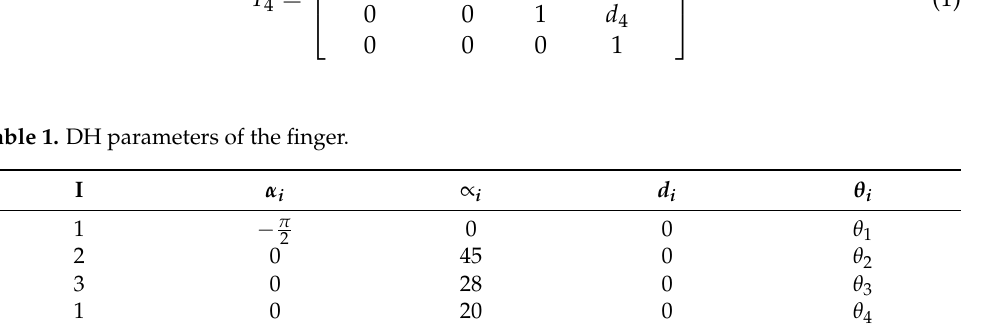
Table 2. Angles selected for the middle finger.